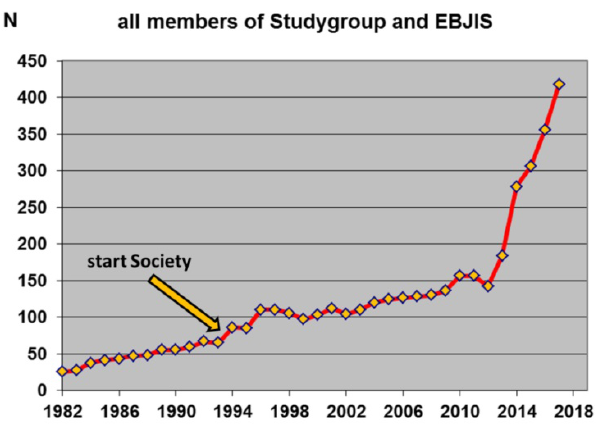
Figure 3. All Members of Study Group and Society: Increase after the Start of the Society in 1993, and after 2013.